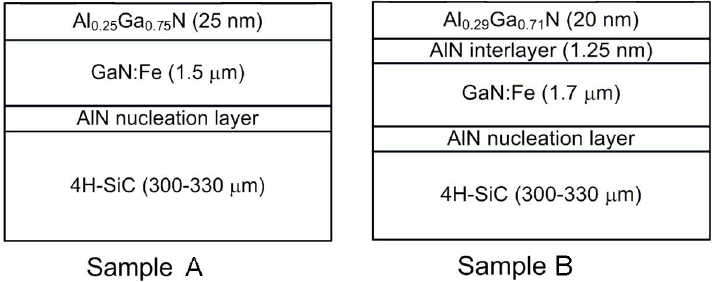
Figure 1. Schematic cross section description of used AlGaN/GaN heterostructures.